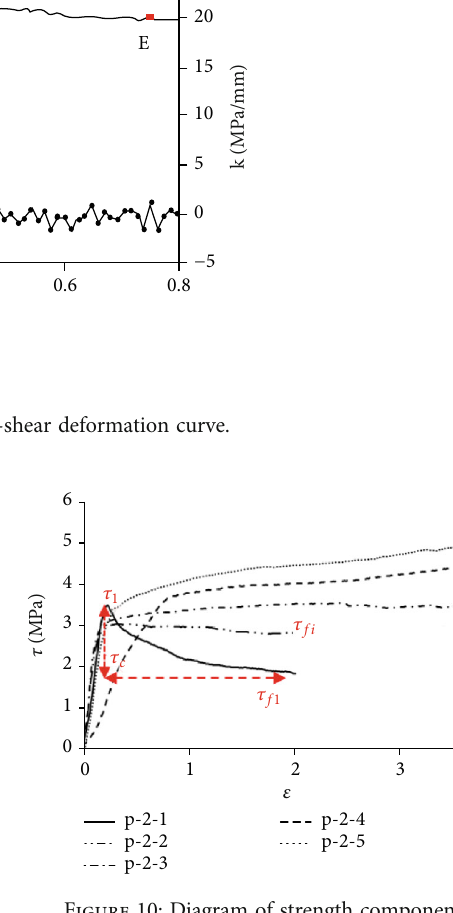
Figure 10: Diagram of strength